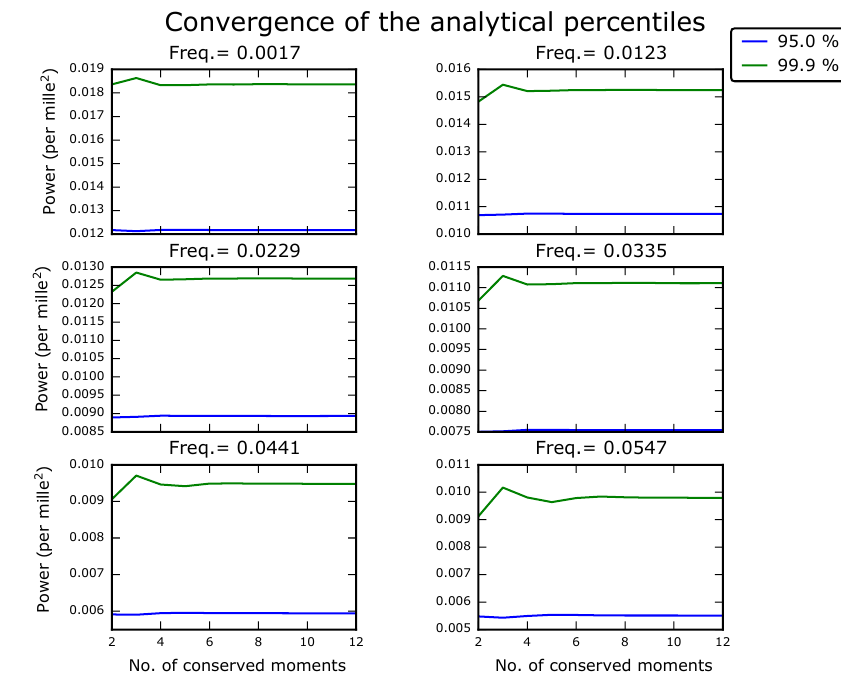
Figure 9. At six particular frequencies, check for the convergence of the analytical percentiles.